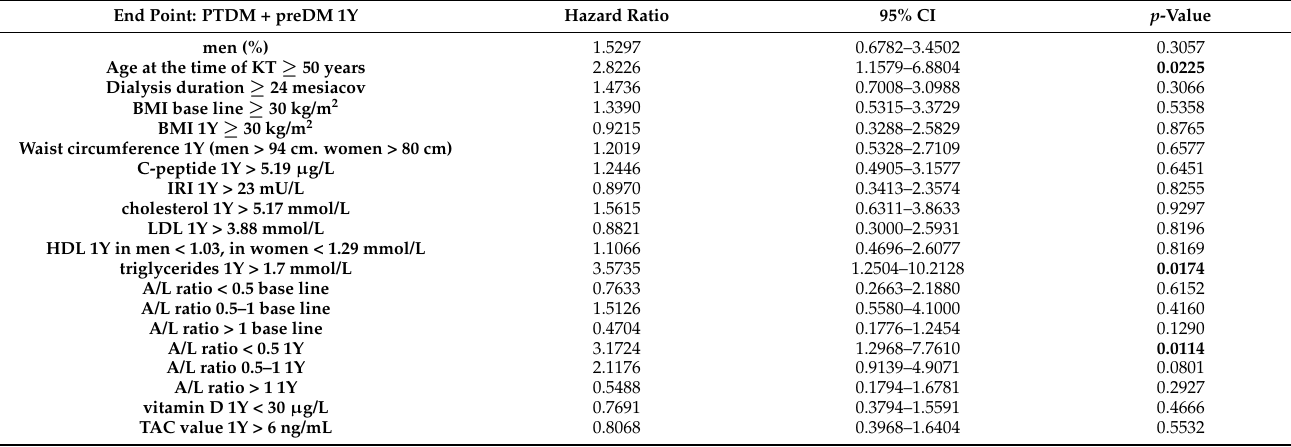
Table 3. Cox regression Hazard